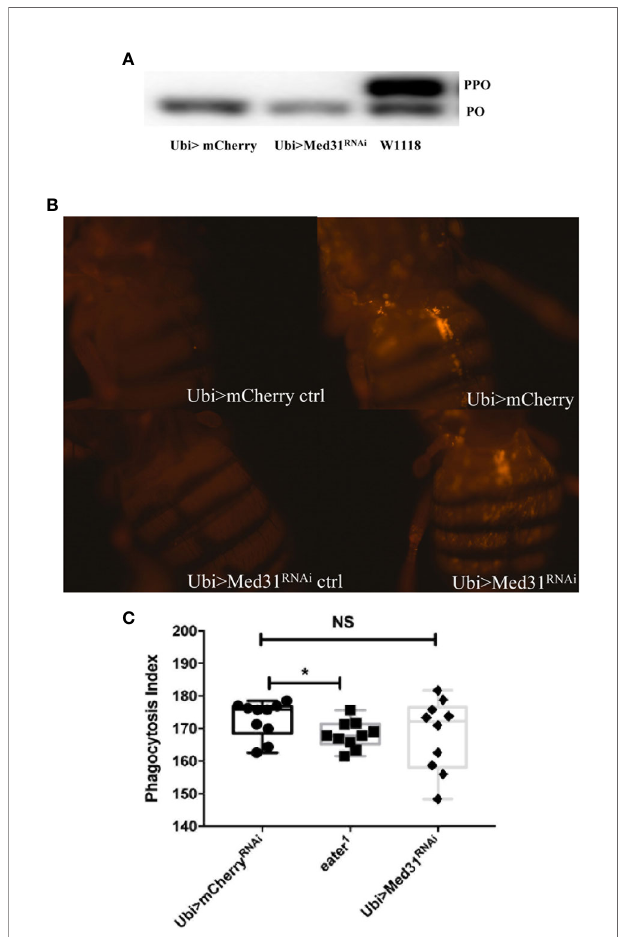
FIGURE 4 | Melanization and phagocytosis are not affected in Med31 RNAi fl ies. (A) prophenol oxidase (PPO) cleavage four hours after a M. luteus challenge was detected by Western blot analysis. The cleavage of PPO into phenol oxidase (PO) is shown in the picture. PPO cleavage into PO was total for both Med31 RNAi and mCherry RNAi control fl ies, while that induced in another wild-type control, w1118, was only partial. This blot is representative of three out of four independent experiments. The phagocytic activity of fl ies was detected using injected pH-RODO-labelled E. coli , which become fl uorescent when internalized into mature phagosomes. (B) Flies were injected with latex beads as a phagocytosis-de fi cient control (left panels). The phagocytic activity of Med31 RNAi fl ies was not altered compared to the mCherry RNAi control fl ies (right panels). (C) Quanti fi cation of the fl uorescence emitted by internalized bacteria. The eater 1 phagocytosis- de fi cient mutant fl ies represent a positive control. There was no signi fi cant difference between Med31 RNAi fl ies and the mCherry RNAi control fl ies. Each dot represents the fl uorescence measured in a single fl y. Three independent experiments were performed. *P < 0.05. Median ± SEM are indicated. NS: not signi fi